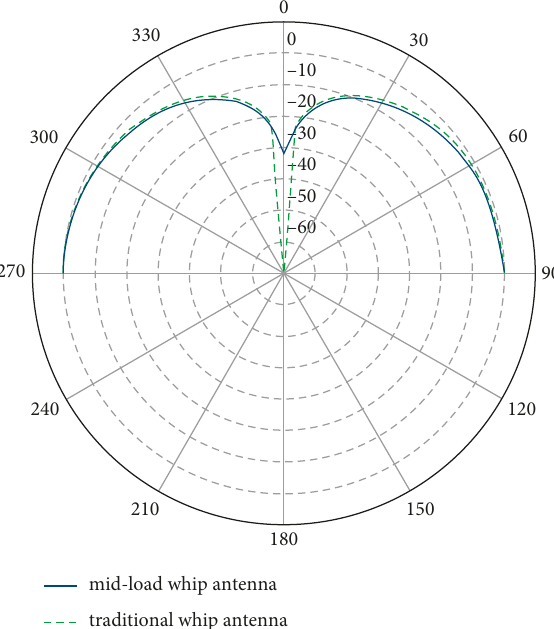
Figure 6: Directivity comparison between the midload whip an- tenna and the traditional whip antenna.